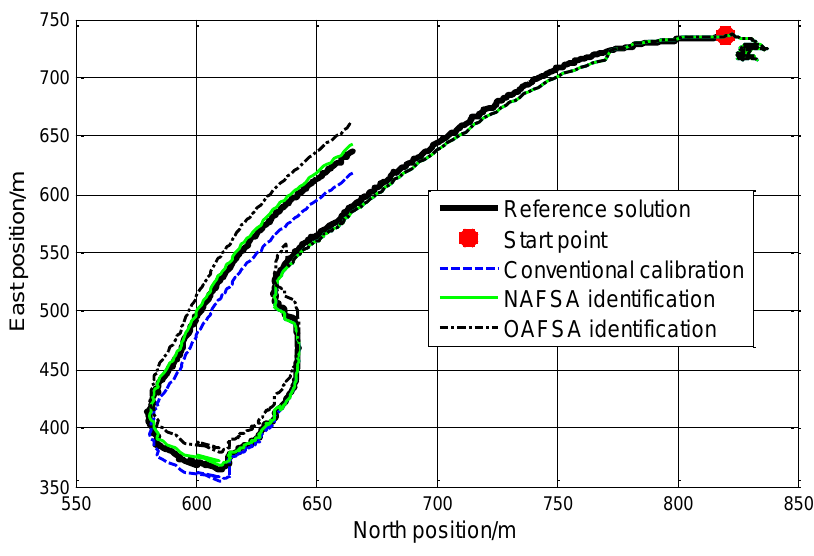
Figure 7. Trajectory comparison between different